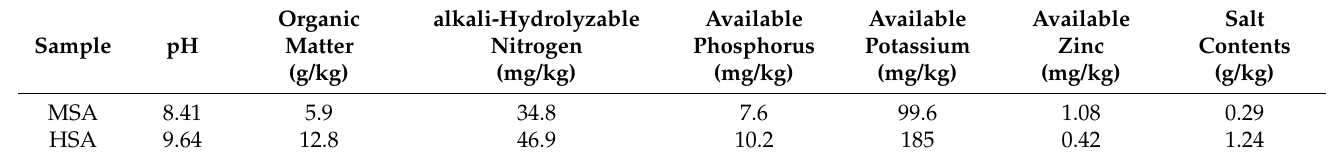
Table 1. Basic nutrient status of the